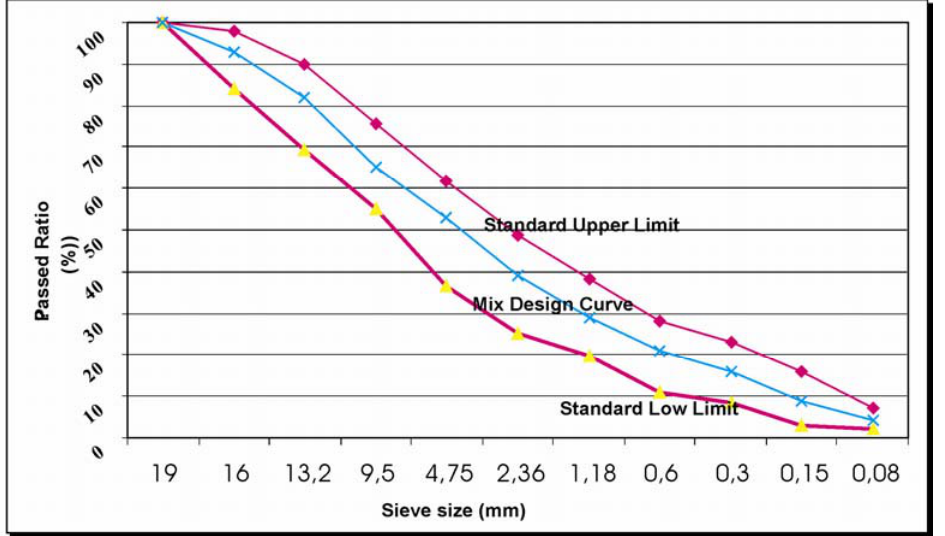
Fig 2. Data of aggregate (limestone and steel slag particles) sieve analysis